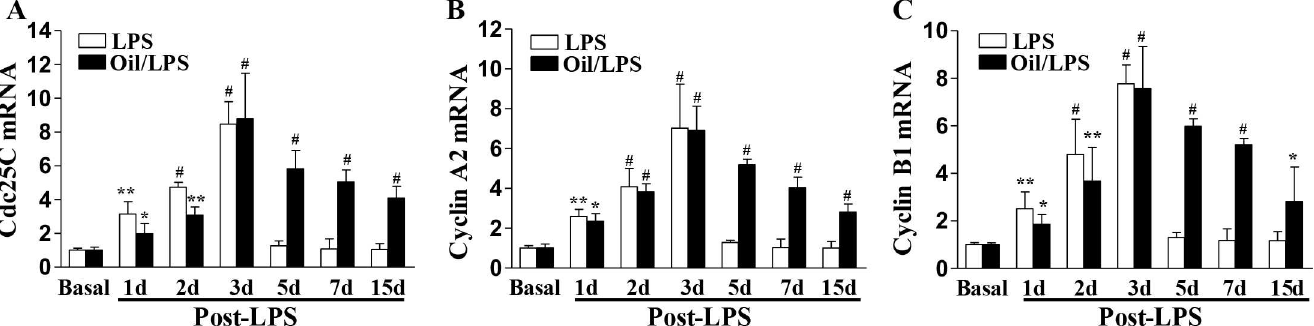
Fig 6. Expression of cell cycle genes in mouse lungs. At designated times post-LPS challenge, lungs were collectedfor RNA isolationand QRT-PCR analysisof Cdc25C, CyclinA2, and Cyclin B1 mRNA. Data are expressed as mean ± SD (n = 4/group). * , P < 0.05; ** , P < 0.01; #, P < 0.001 versus basal with or without corn oil,